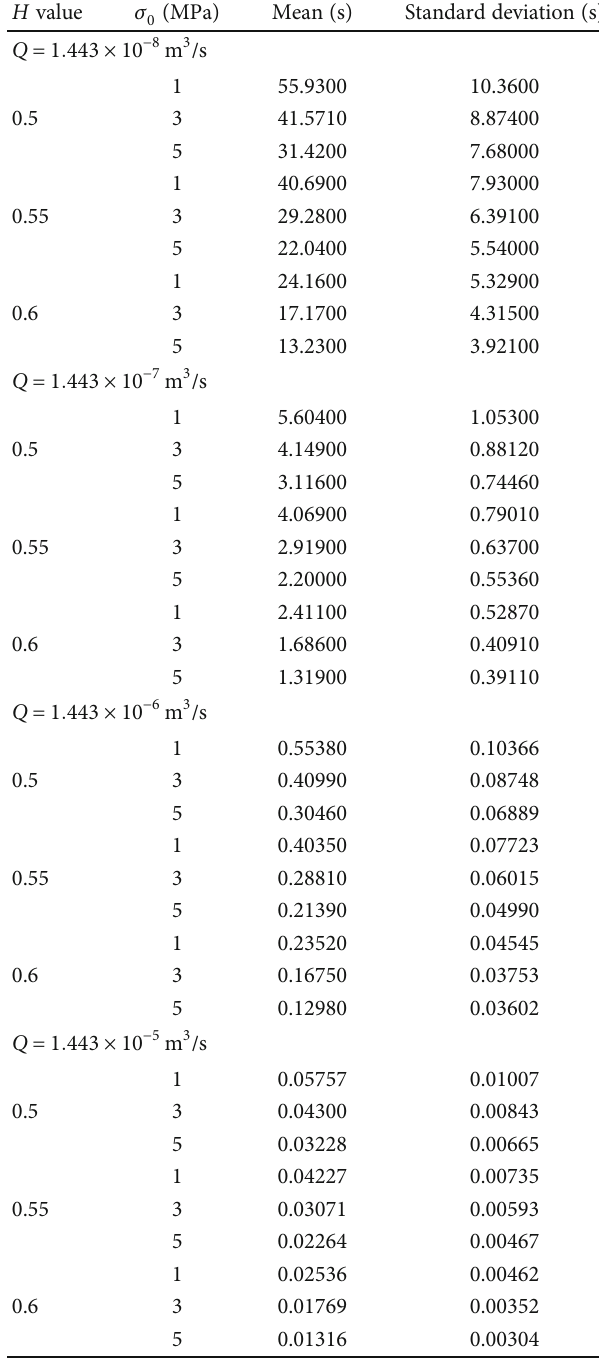
Table 3: The mean and standard deviations of particle travel